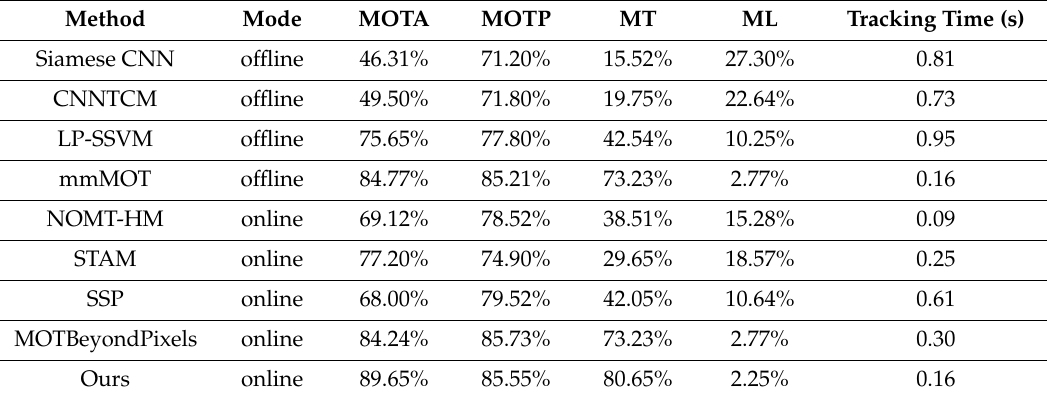
Table 3. Comparison with state-of-the-art methods using the KITTI tracking testing set.